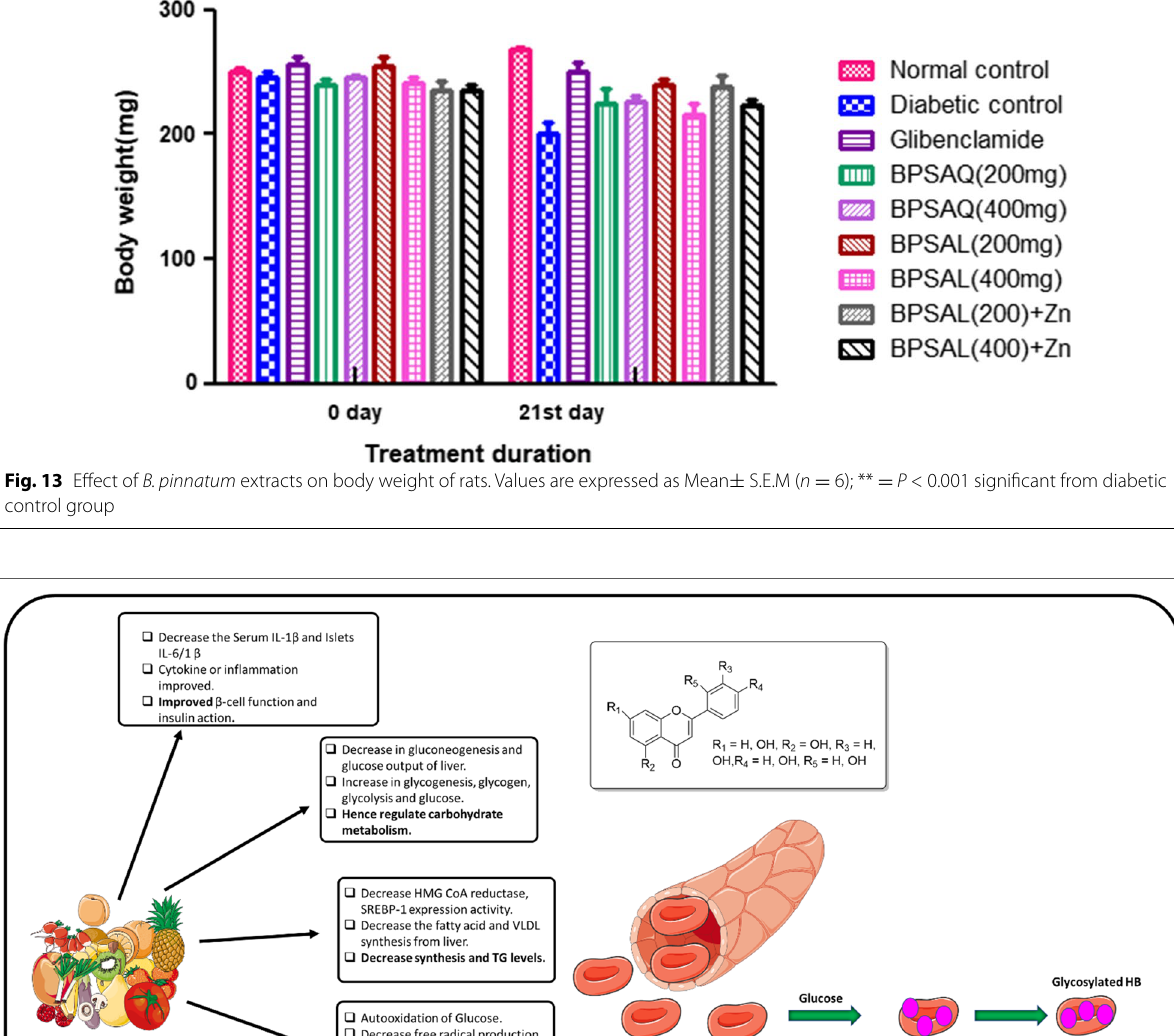
Fig. 14 Sources of dietary flavonoids. These flavonoids possess antidiabetic and antioxidant effects by various mechanisms such as inhibition of serum IL-1β and IL-6/1β, enhancing the β-islets cells, inhibition of gluconeogenesis and glucose release in blood from liver, stimulation of glycogenesis, inhibition of HMG-CoA reductase and SREBP-1, reduction in the level of triglycerides, stimulation of glucose sensitivity by stimulation of phosphorylation IRS and PI3K-PKB/Akt pathways,